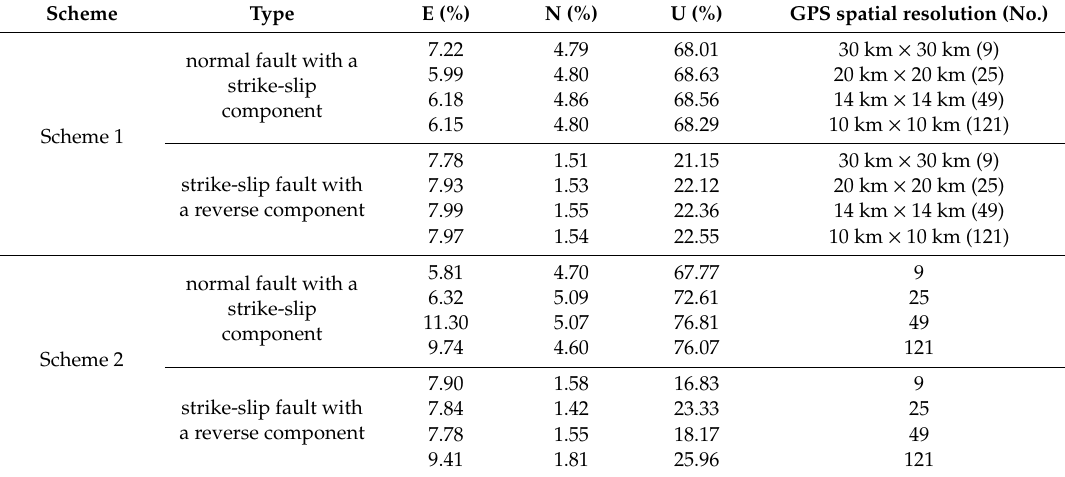
Table 3. The Per in the normal fault with a strike-slip component and strike-slip fault with a reverse component for two schemes.